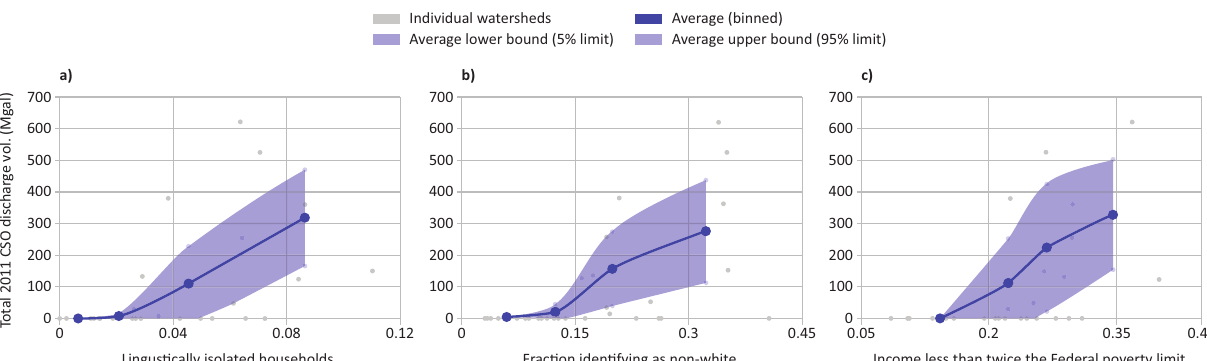
Figure 4. CSO discharge volumes versus EJ criteria across